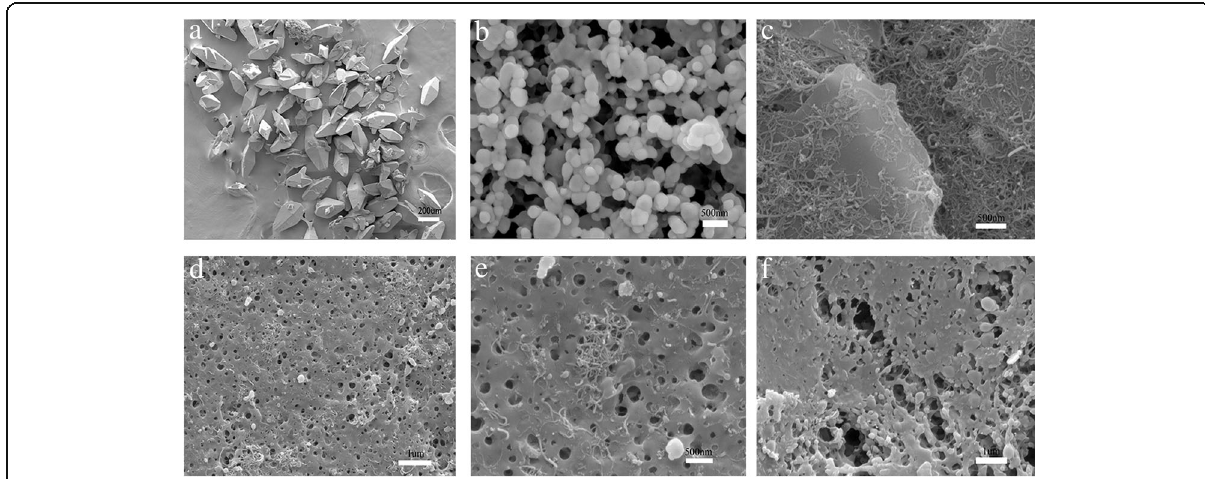
Fig. 2 SEM morphologies of CL-20, the mixture of rGO and CNT, and CL-20-based composites: a raw CL-20; b milled CL-20; c rGO + CNT; d , e CL-20/CNT; and f CL-20/rGO+